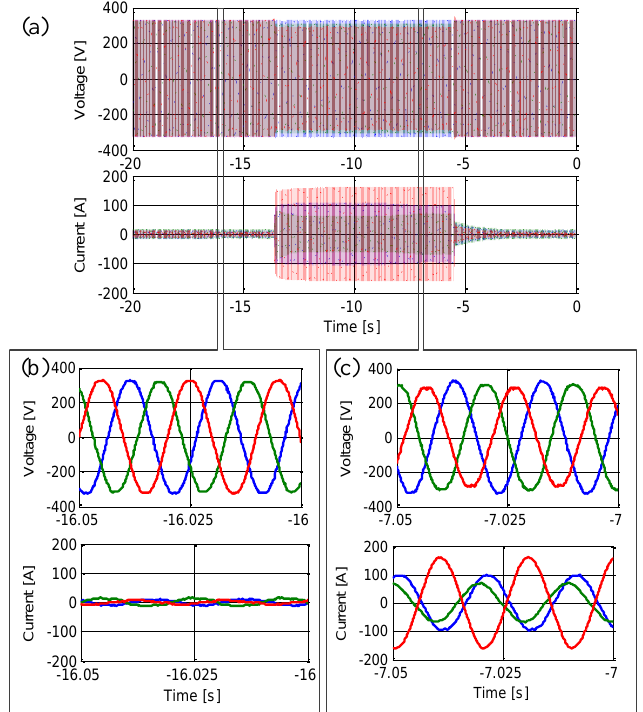
Figure 14. Single SPC-based converter working. The PCC voltage and current injection when A pos = 1 and A neg = 10 A pos : ( a ) the whole experimental process; ( b ) prior to the fault; and ( c ) during the fault.